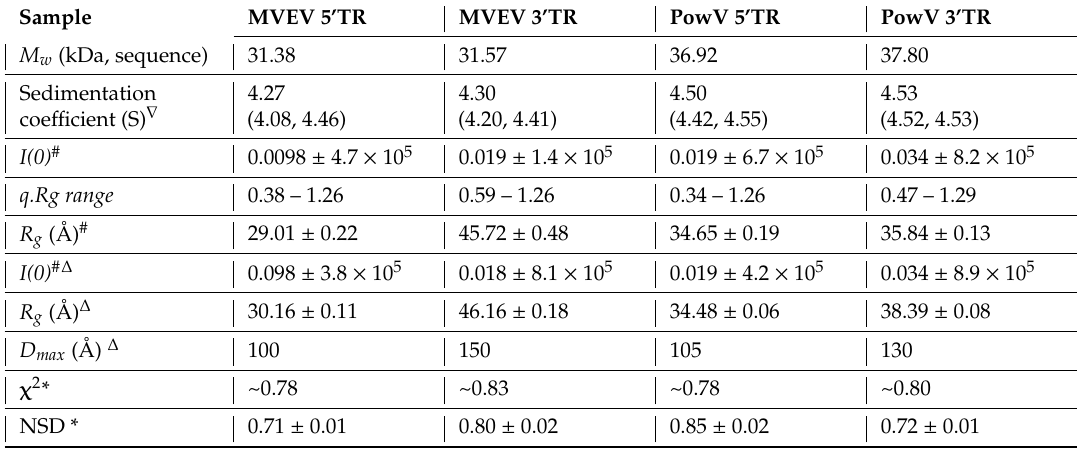
Figure 3. Characterization of MVEV and PowV terminal regions using small-angle X-ray scattering (SAXS). ( A ) A plot of scattering intensity (Log I ( q )) versus scattering angle ( q = 4 π sin θ / λ ) representing merged SAXS data for MVEV and PowV. ( B ) Guinier plots (plot of ln ( I ( q )) versus q 2 ) representing the homogeneity of samples and allowing determination of R g based on the low-angle region data. ( C ) Dimensionless Kratky plots ( I ( q ) / I ( 0 )*( q * R g ) 2 vs q * R g ) for all four RNA samples demonstrating their extended structures. ( D ) Pair-distance distribution ( P ( r )) plots for all four RNA samples representing their maximal particle dimensions and allowing the determination of R g from the entire SAXS dataset. Table 1. Biophysical parameters of MVEV and PowV non-coding